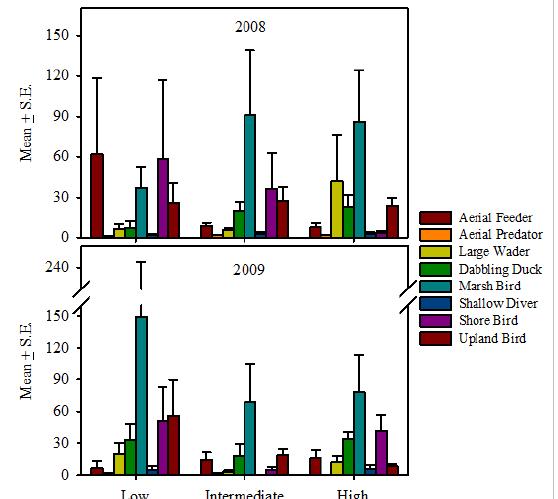
Figure 6. Average abundance of eight bird foraging guilds observed (wetland surveys) by management intensity on wetland areas of Wetlands Reserve Program easements in California’s Central Valley. 2008 includes Sacramento, San Joaquin, and Tulare sub-basin data, whereas 2009 includes Sacramento and San Joaquin sub-basin data only. Low = sites with low or no management, Intermediate = sites with intermediate management, High = actively managed sites. Foraging guilds are comprised of species that share behavioral traits and have similar environmental requirements [13]. Standard error bars are